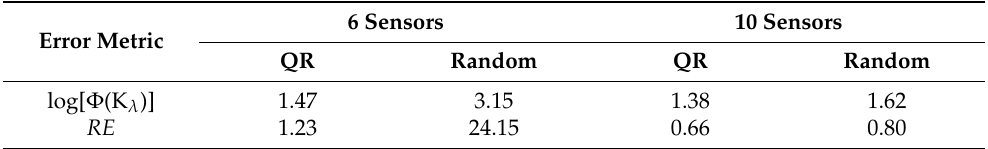
Table 4. Logarithm of condition number of K λ and relative reconstruction errors (%) of random placement and QR pivoting in velocity field (Boundary Condition 1).